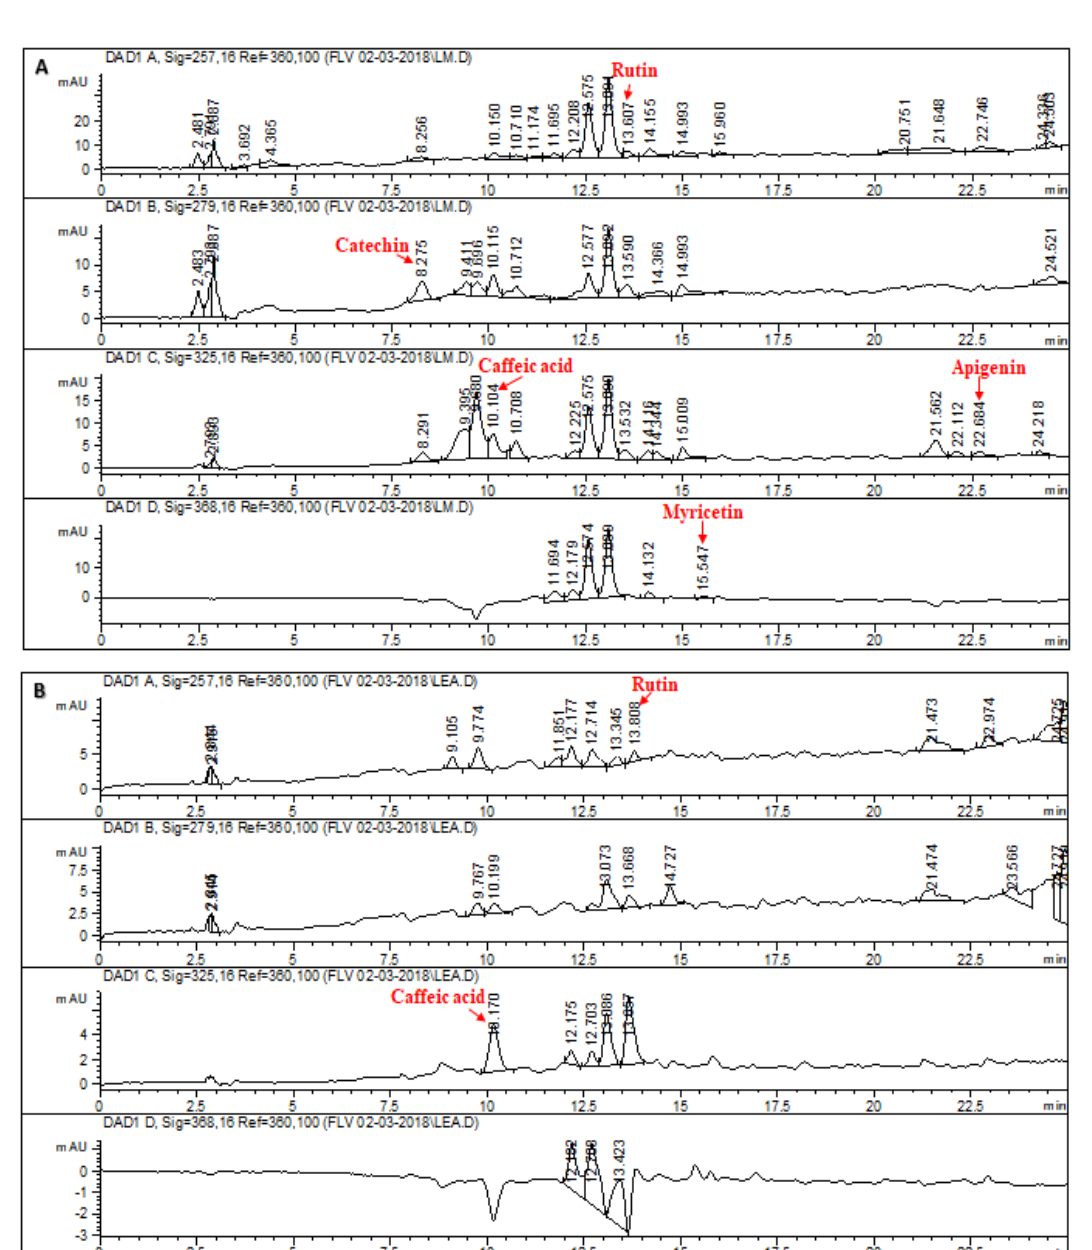
Figure 1. HPLC–DAD profile of reference standards for crude extracts and derived fractions of L. corymbulosum (LCM, LCE, LCB and LCA) at varying wavelengths. Signal 1: 257λ, signal 2: 279λ,